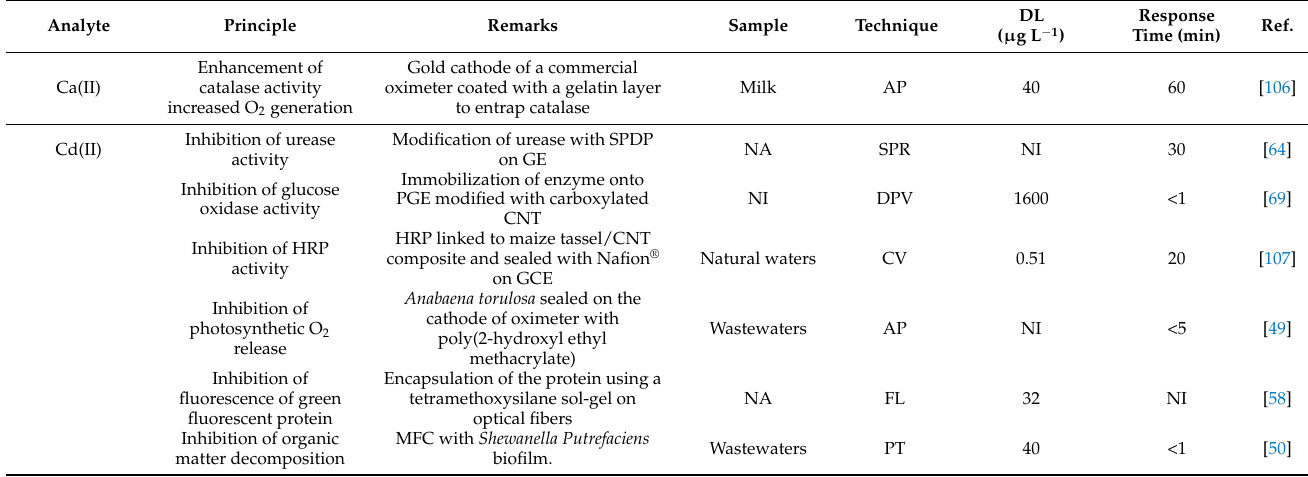
Table 2. Selected applications of biosensors based on catalysis and